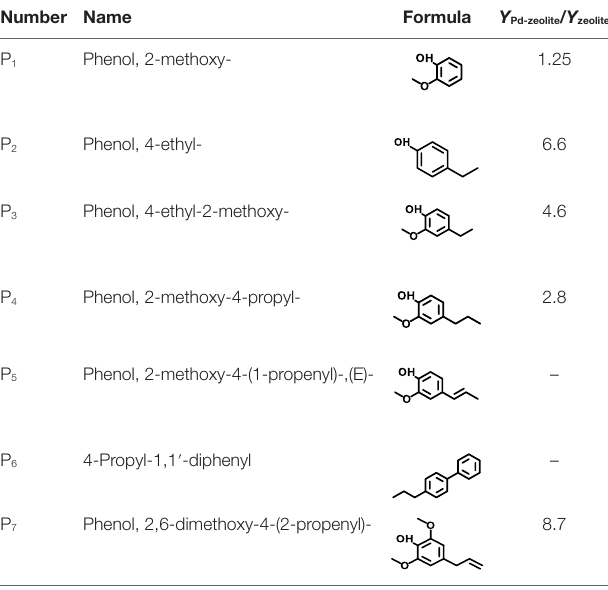
TABLe 1 | The major products from lignin conversion.